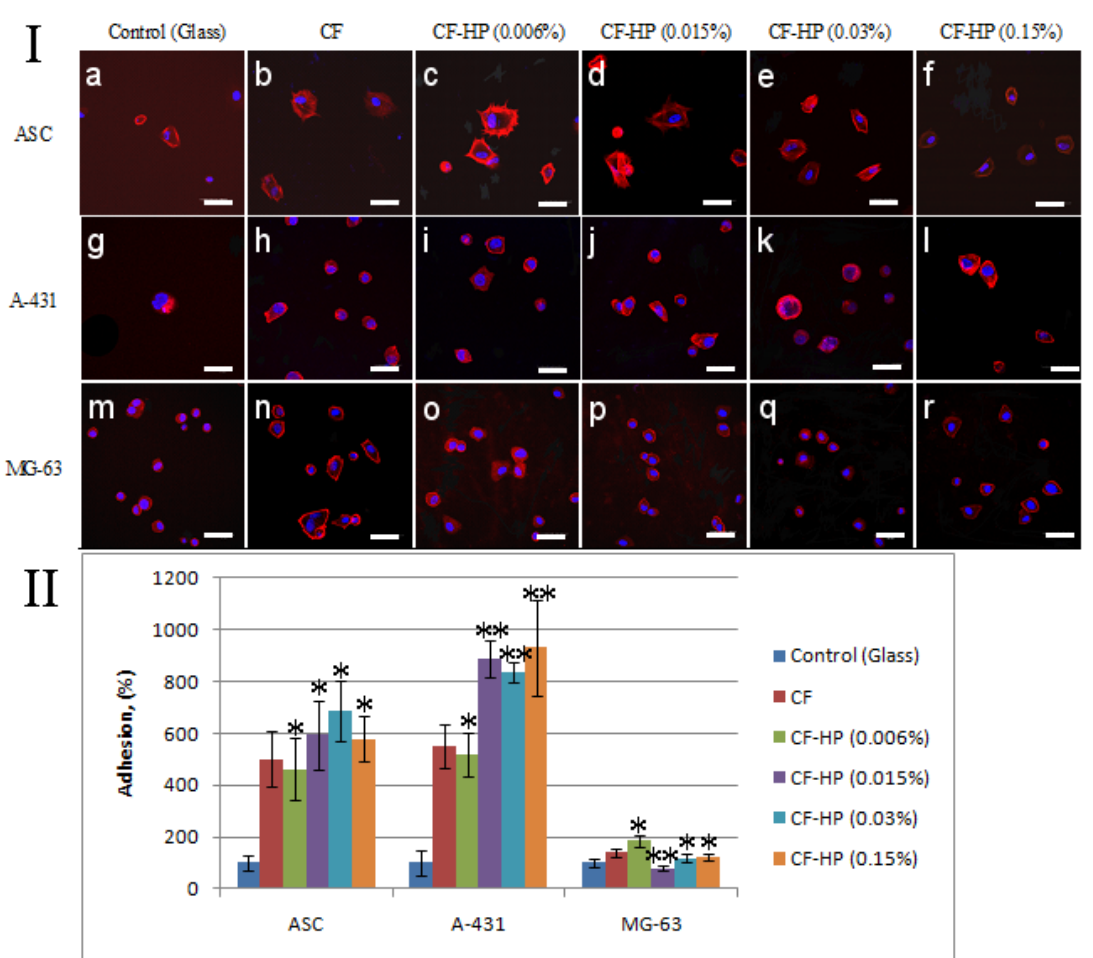
Figure 5. ( I ) Fluorescence micrographs of cells with actins (red) and nuclei (blue) stained after 1 h cultivation: ( a ) ASCs on the pure glass, ( b ) ASCs on the pristine CF, ( c ) ASCs on CF after HP treatment with concentration 0.006%, ( d ) ASCs on CF after HP treatment with concentration 0.015%, ( e ) ASCs on CF after HP treatment with concentration 0.03%, ( f ) ASCs on CF after HP treatment with concentration 0.15%, ( g ) A-431 on the pure glass, ( h ) A-431 on the pristine CF, ( i ) A-431 on CF after HP treatment with concentration 0.006%, ( j ) A-431 on CF after HP treatment with concentration 0.015%, ( k ) A-431 on CF after HP treatment with concentration 0.03%, ( l ) A-431 on CF after HP treatment with concentration 0.15%, ( m ) MG-63 on the pure glass, ( n ) MG-63 on the pristine CF, ( o ) MG-63 on CF after HP treatment with concentration 0.006%, ( p ) MG-63 on CF after HP treatment with concentration 0.015%, ( q ) MG-63 on CF after HP treatment with concentration 0.03%, ( r ) MG-63 on CF after HP treatment with concentration 0.15%. ( II ) Statistics of cell adhesion on surfaces with different functional groups after 1 h cultivation. (n = 5: *— p < 0.01, **— p < 0.05 compared with the unmodified CF.) Staining—rhodamine-phalloidin (red), 40,6-diamidino-2-phenylindole (DAPI) (blue). Scale bar 50 μ m.